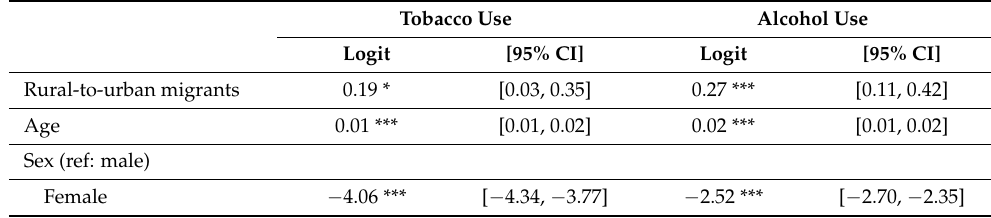
Table 2. The effect of migration status on tobacco use and alcohol